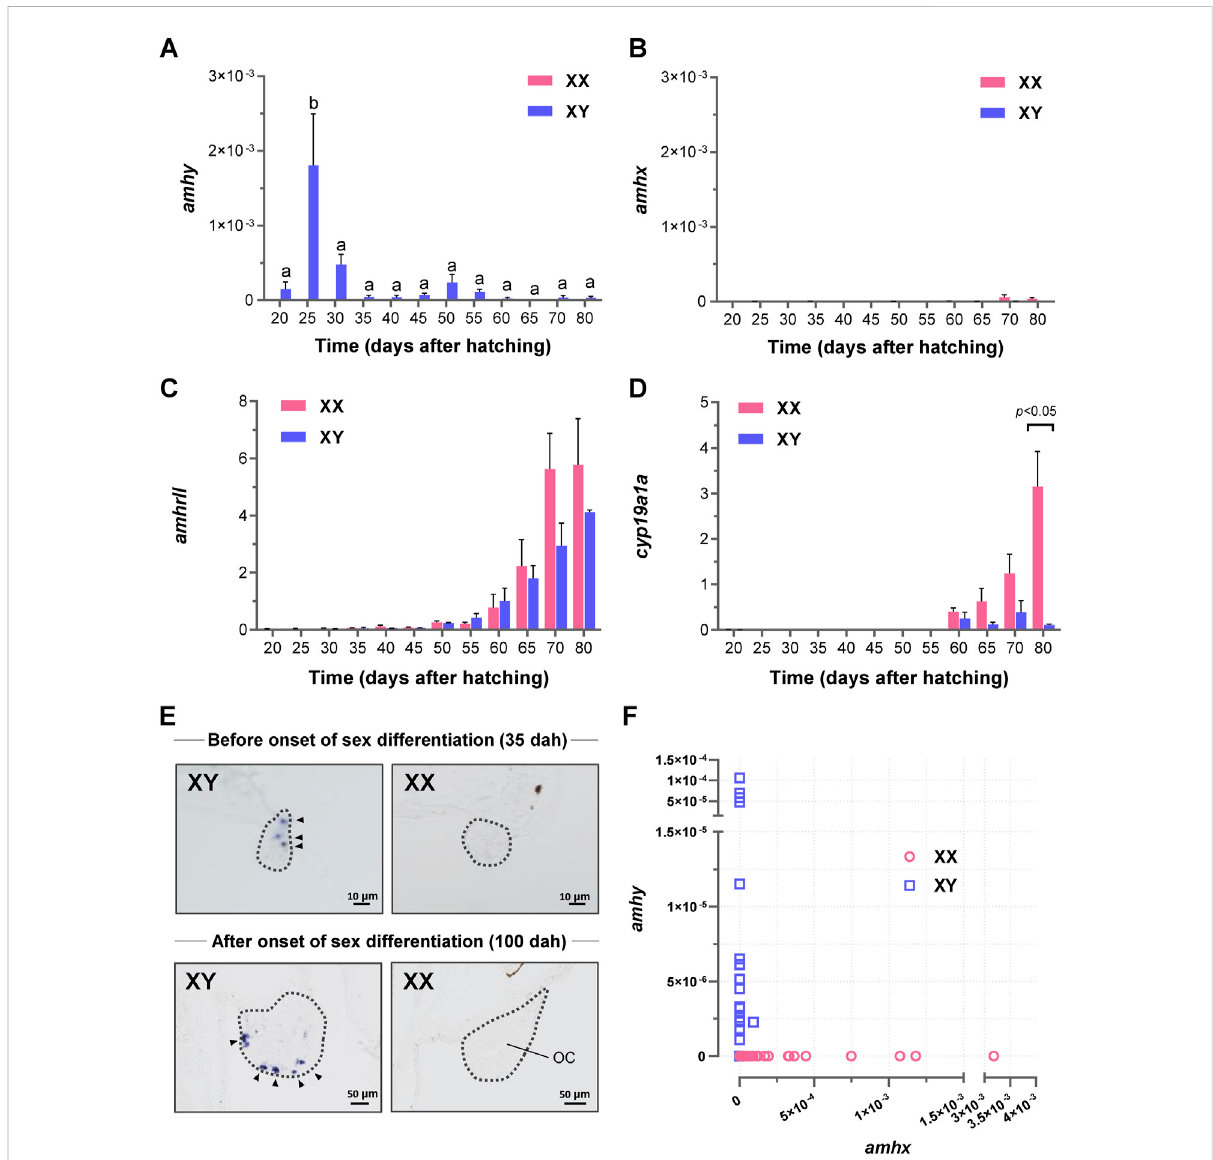
FIGURE 3 Expression analysis of amhy, amhx, amhrII , and cyp19a1a mRNA during sex differentiation in P. olivaceus . Expression pro fi ling by qRT-PCR in larvae trunks showed (A) amhy expression only in XY genotypes with a peak at 25 dah. (B) amhx was almost undetectable during the same period; weak expression was detected at 70 and 80 dah. (C,D) Quantitative analysis of amhrII and cyp19a1a mRNAs during the same period; sexually dimorphic expression was detected only for cyp19a1a , at 80 dah XX samples. (E) Spatial localization of amh riboprobe restricted to XY gonads before and after the onset of sex differentiation; at 100 dah, signals were recognized at the ventral edge of the XY gonad, where germ cells are distributed to form cysts. In XX gonads, which had a clear ovarian cavity (OC), no detectable signals of amh were found. (F) the relationship between amhy and amhx expression in XY in relation to amhx in XX; although absolute expression values were generally lower than amhy , for some reason more XX individuals were expressing amhx than XY. Differences were considered as signi fi cant for p < 0.05 by One-Way ANOVA with Turkey post-